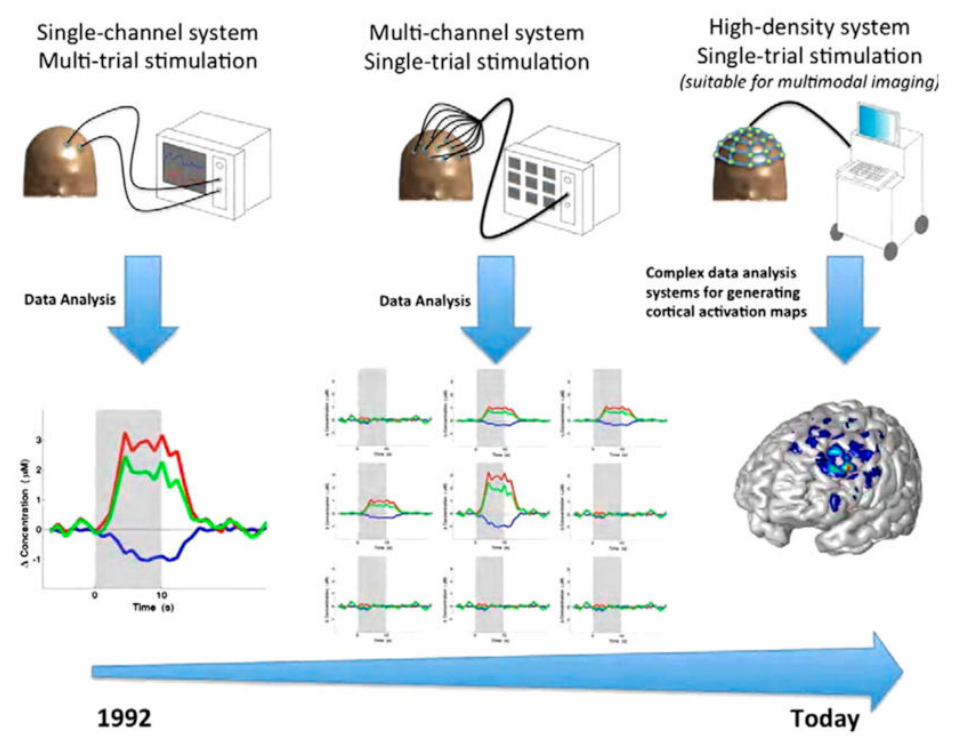
Figure 4. The development of fNIRS imaging over time. (Reprinted with permission from ref. [1], Copyright 2012 Elsevier).